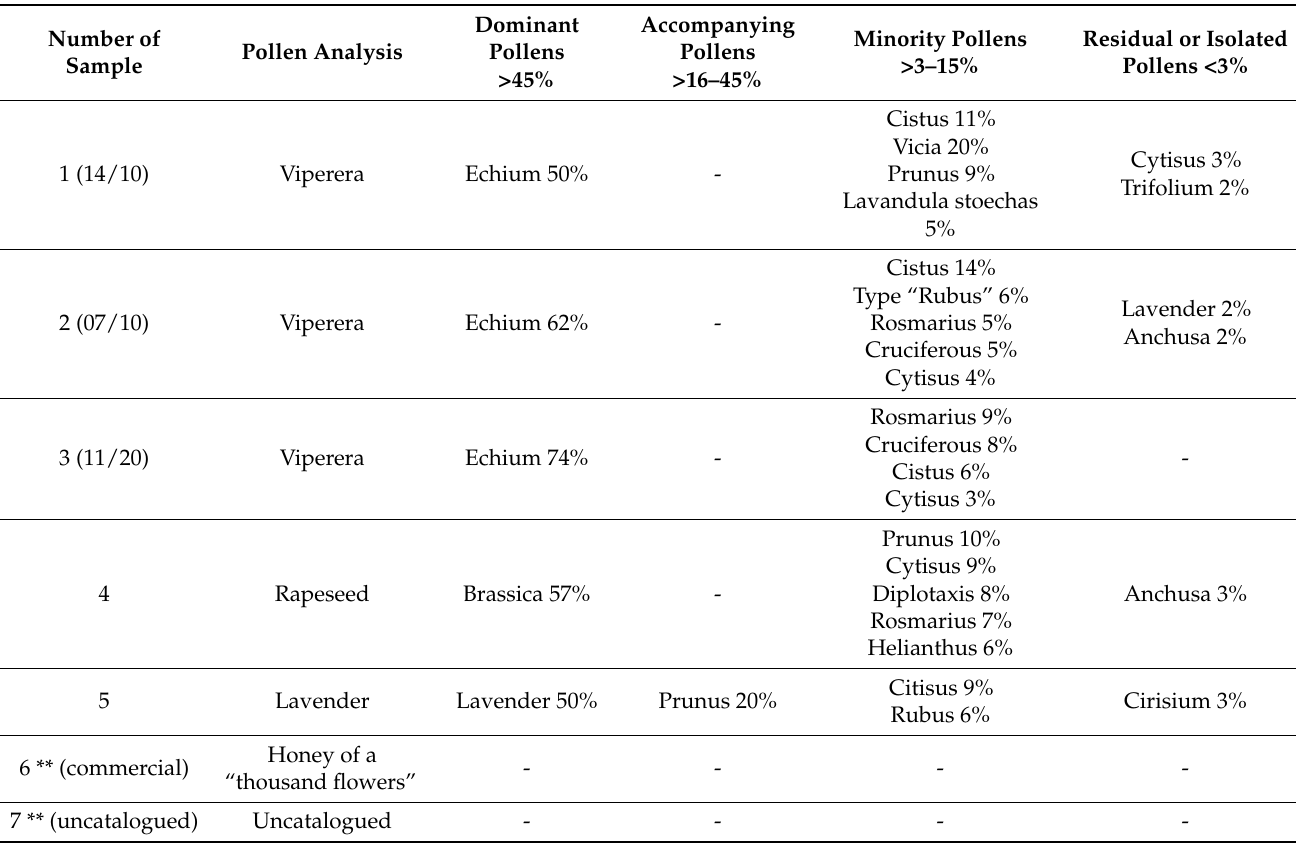
Table 2. Pollen analysis of the analyzed